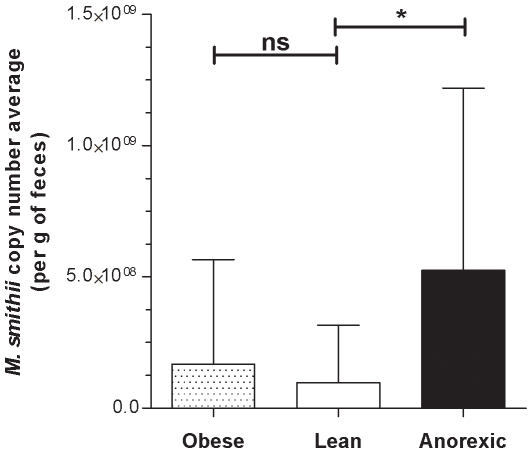
Quantification of the archaeon M. smithii species.Values are means±SD. P value <0.05 is represented as * and P value > 0.05 is indicated by “ns” for not significant.